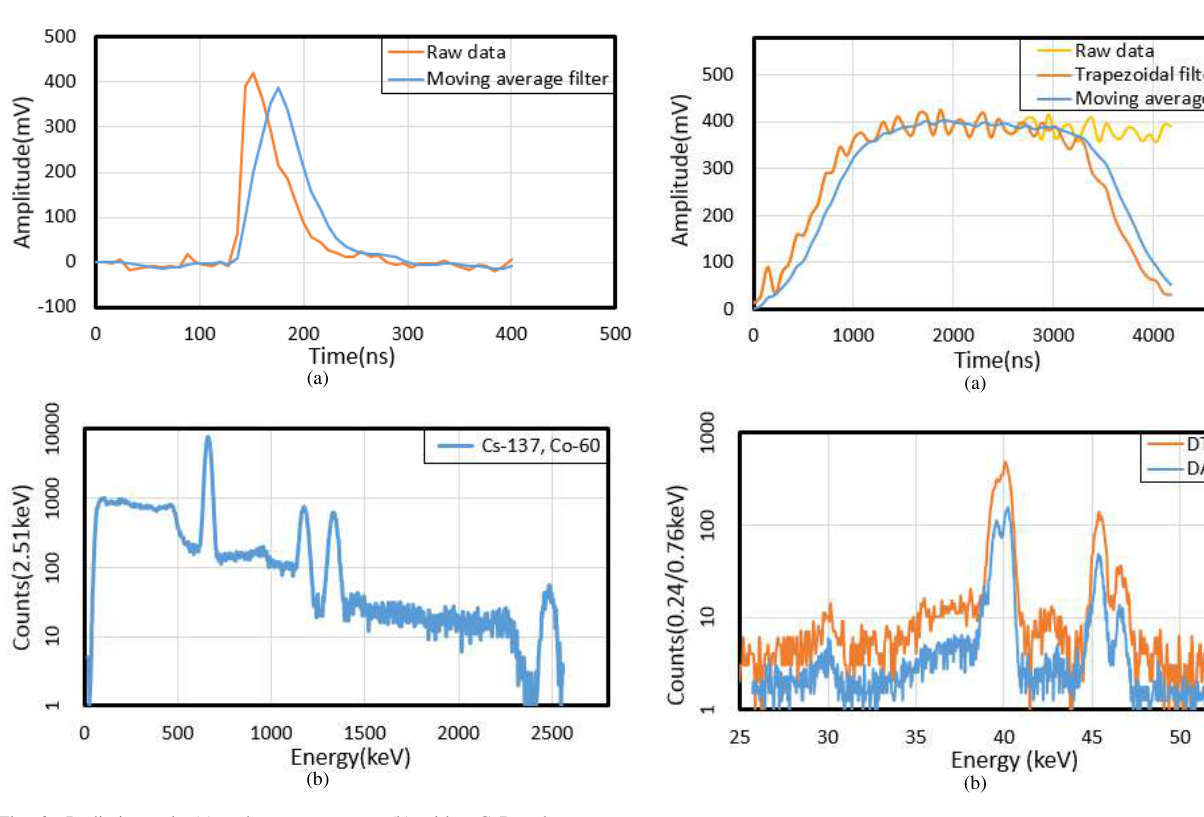
peaks, 39.5 keV and 40.1 keV, are discriminated on the blue line but overlapped in orange line. Meanwhile, the acquired data from DAQ125 shows better performance at peaks 45.4